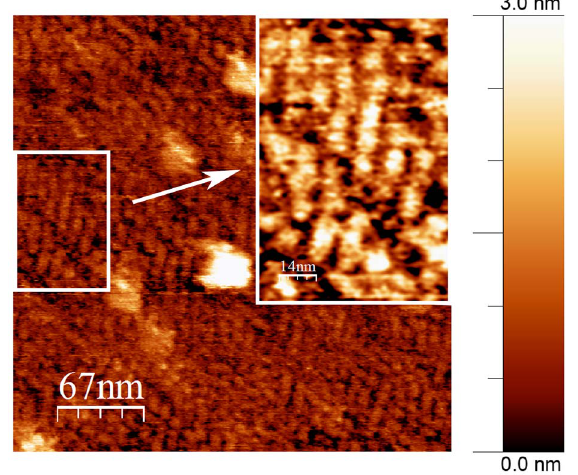
Figure 9. AFM topography image of M1 protein structures formed at negatively charged surface. The inset displays a magnification of the region outlined by white frame.